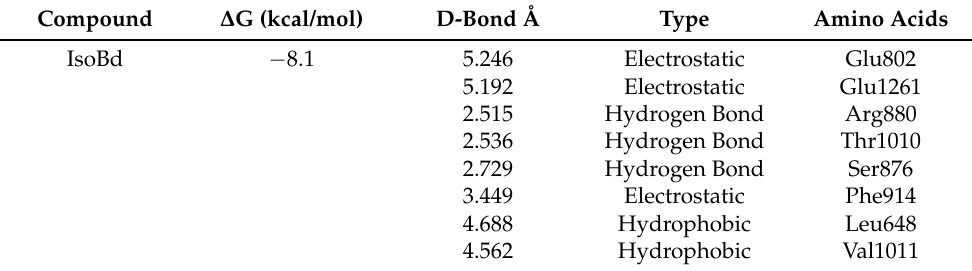
Table 7. Docking results of binding of IsoBd to active site of xanthine